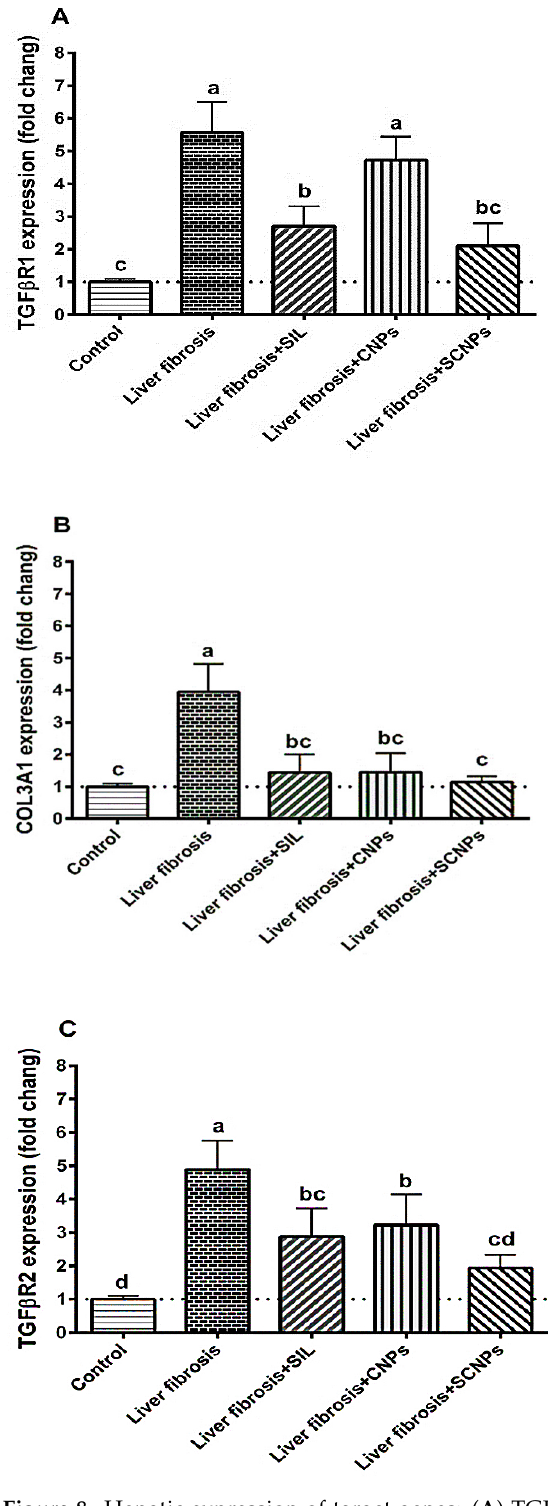
Figure 8. Hepatic expression of target genes: ( A ) TGF β R1; ( B ) COL3A1; and ( C ) TGF β R2. Data are presented as mean ± SD ( n = 6). The means of the groups in the same column with the same superscript letter are not significantly different, while the means with different letters are significantly differed according to the ANOVA test, followed by the post hoc test (Tukey). At p ≤ 0.05, the difference was statistically significant. Abbreviations: TGF β R1, transforming growth factor-beta receptor I; COL3A1, collagen type III alpha 1; TGF β R2, transforming growth factor-beta receptor II.